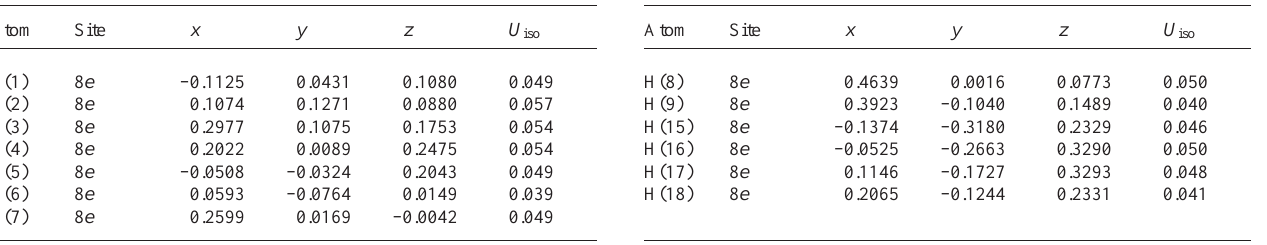
Table 2. Atomic coordinates and displacement parameters (in Å 2 )